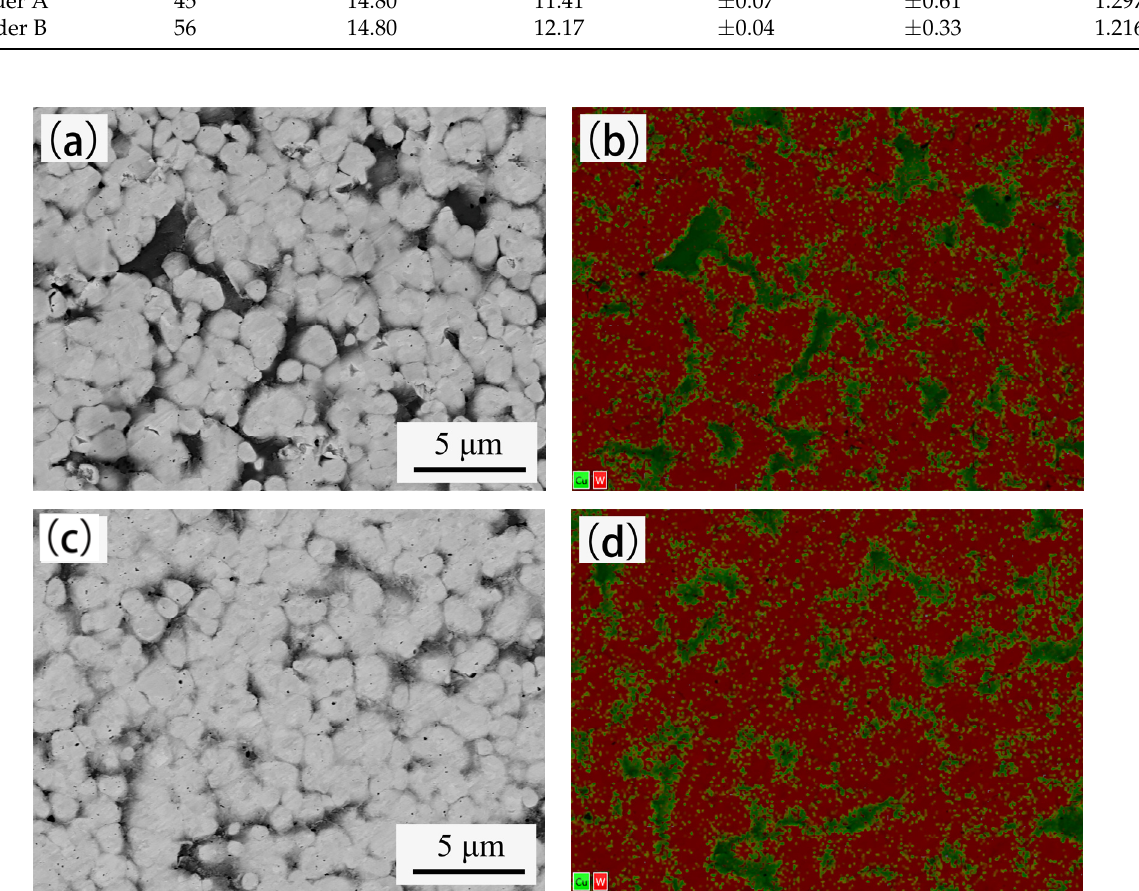
Figure 7. Back-scattered electron images (BEI) and elemental mapping of sintered W-20% Cu composite ( a , b ) via powder A; ( c , d ) via powder B.